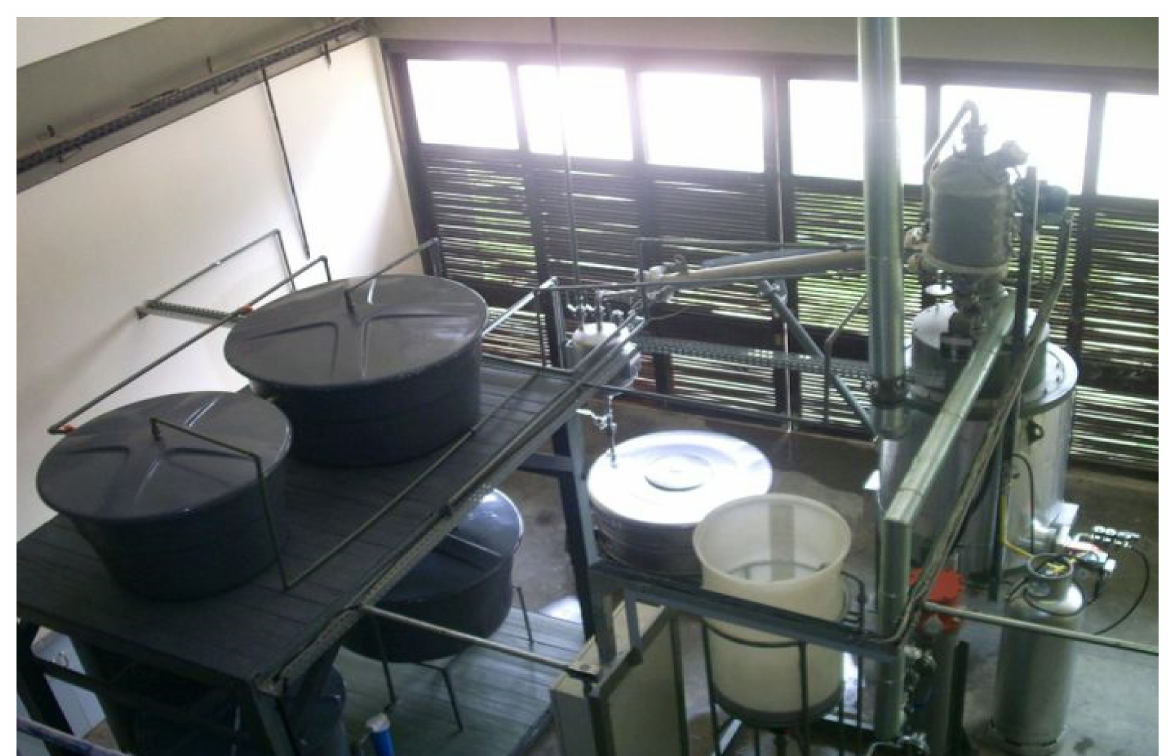
Figure 5. View of the pyrolysis unit in pilot